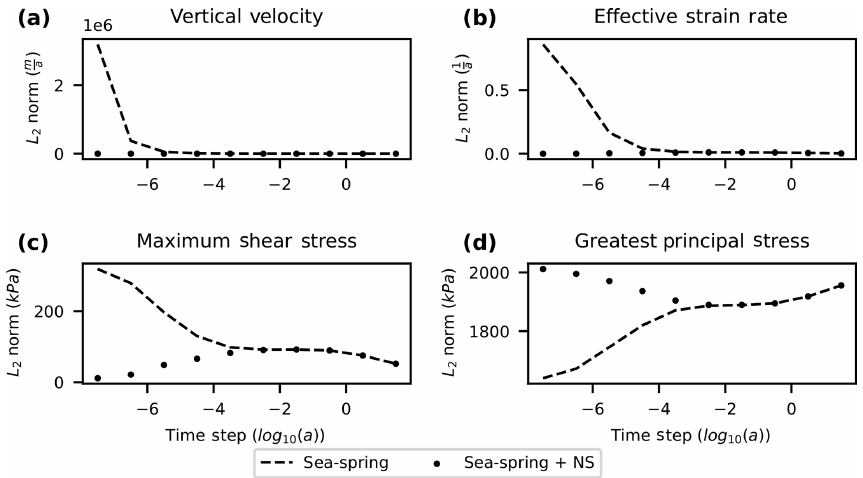
Figure 2. L 2 norm of (a) vertical velocity, (b) effective strain rate, (c) maximum shear stress, and (d) greatest principal stress immediately after the emulated calving event. The norm is calculated based on cell-averaged values. Solutions after a single time step are shown for sea- spring damping and sea-spring with Navier–Stokes (NS) for time step size ranging from 1s to 30 years. The sea-spring with Navier–Stokes term gives physical solutions for all time steps but still shows variability with a time step consistent with the evolution of the